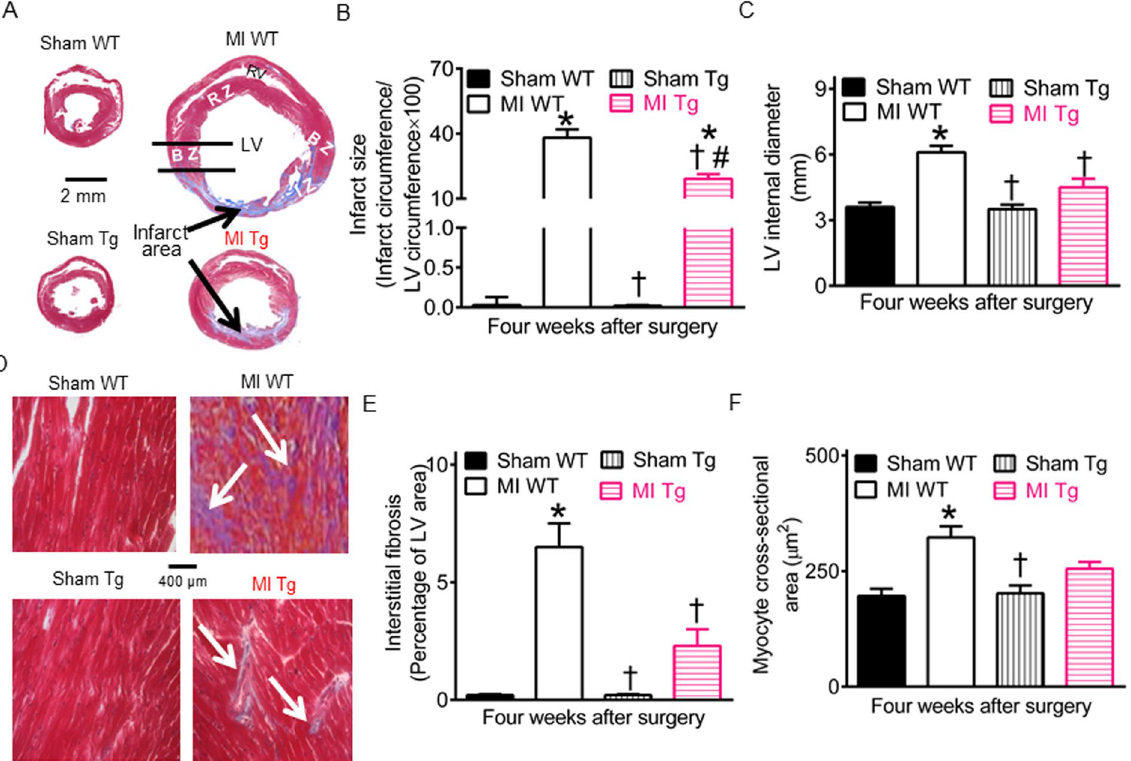
Figure 3. Effects of GTP cyclohydrolase 1 (GCH1) overexpression on myocardial infarct size and interstitial fibrosis after myocardial infarction (MI). ( A ) Representative Masson’s trichrome-stained cross section of the heart showing infarct area with fibrosis. The scale bar shows 2 mm, and the arrows indicate infarct area with fibrosis. BZ, border zone; IZ, infarct zone; LV, left ventricle; RV, right ventricle; RZ, remote zone; ( B ) Infarct size expressed as a percentage of infarct circumference/total circumference of the LV; ( C ) LV internal diameters at the papillary muscle levels; ( D ) Masson’s trichrome-stained myocardium showing interstitial fibrosis. The scale bar shows 400 µ m, and the arrows indicate fibrosis; ( E ) Interstitial fibrosis expressed as a percentage of LV area; ( F ) Myocyte cross-sectional area. Mouse hearts were stained with Masson’s trichrome in wild-type (WT) and transgenic (Tg) mice 4 weeks after MI or sham surgery. * P < 0.05 versus sham WT groups; † P < 0.05 versus MI WT groups; # P < 0.05 versus sham Tg groups (n = 8–10